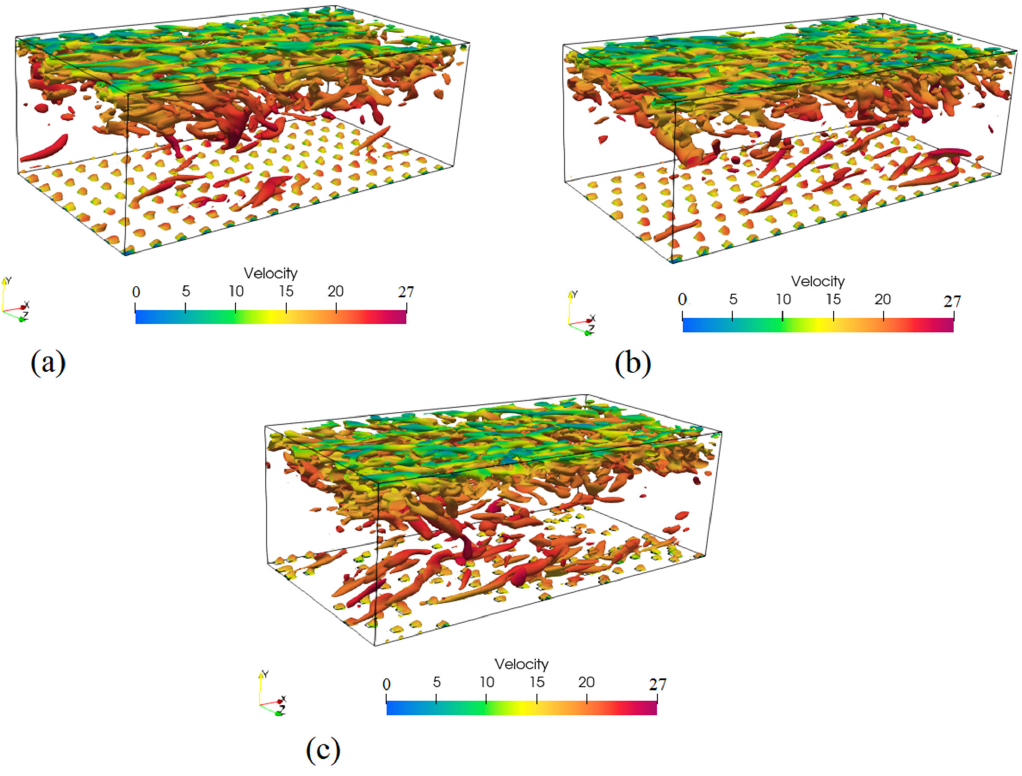
Figure 17. Vortex core isosurface contour of the smooth wall case.